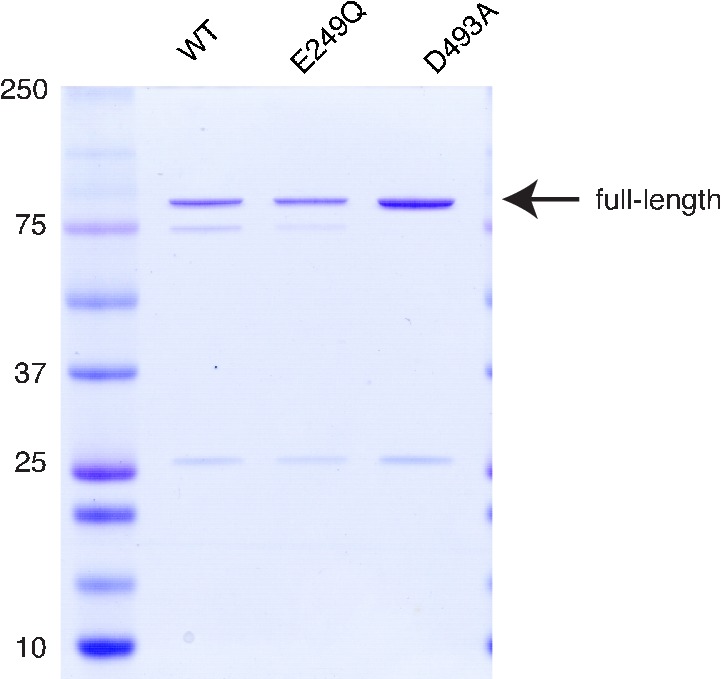
Purification of PfFtsH1.Purified samples were separated by SDS-PAGE and stained with Coomassie. Full-length product is 97 kDa.